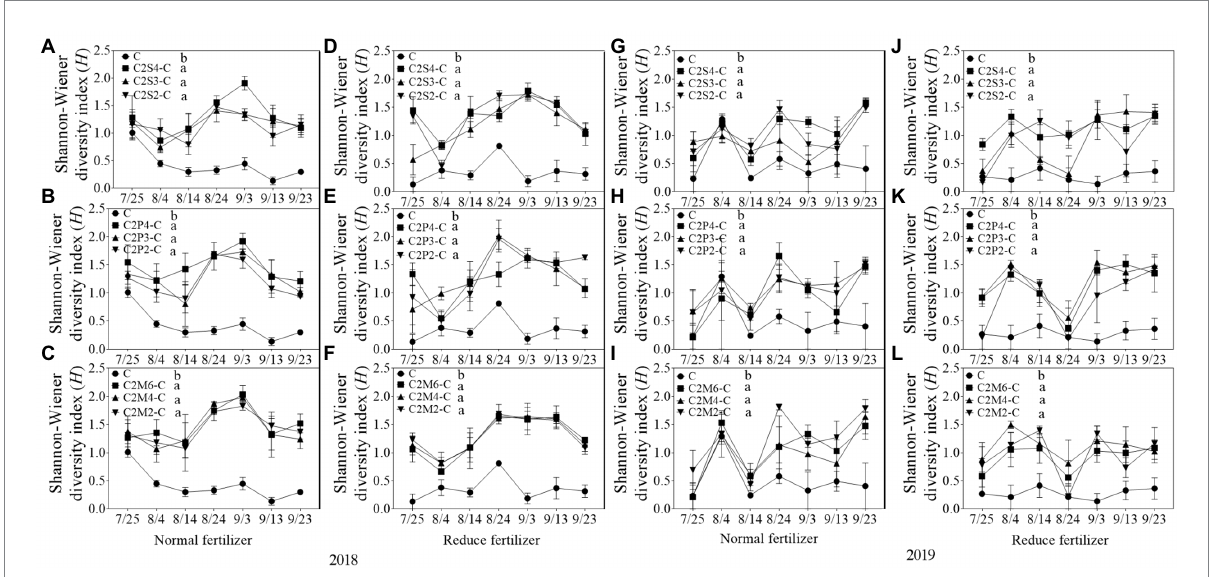
FIGURE 2 Shannon–Wiener diversity index (H) of insect communities on corn plants intercropping with soybean, peanut, and millet under different planting patterns at normal and reduced fertilizer. A-C represent corn-soybean intercropping, corn-peanut intercropping and corn-millet intercropping under normal fertilizer in 2018, respectively. D-F represent corn- soybean intercropping, corn-peanut intercropping and corn-millet intercropping under fertilizer reduction in 2018, respectively. G-I represents corn-soybean intercropping, corn-peanut intercropping and corn-millet intercropping under normal fertilizer in 2019, respectively. J-L represent corn-soybean intercropping, corn- peanut intercropping and corn-millet intercropping under fertilizer reduction in 2019, respectively. C2S2-C, C2S3-C, C2S4-C: corn plants in the planting patterns of 2 corn rows intercropping with 2, 3, 4 rows of soybean; C2P2-C, C2P3-C, C2P4-C: corn plants in the planting patterns of 2 corn rows intercropping with 2, 3, 4 rows of peanut; C2M2-C, C2M4-C, C2M6-C: corn plants in the planting patterns of 2 corn rows intercropping with 2, 4, 6 rows of millet. Different lowercase represents a significantly different average